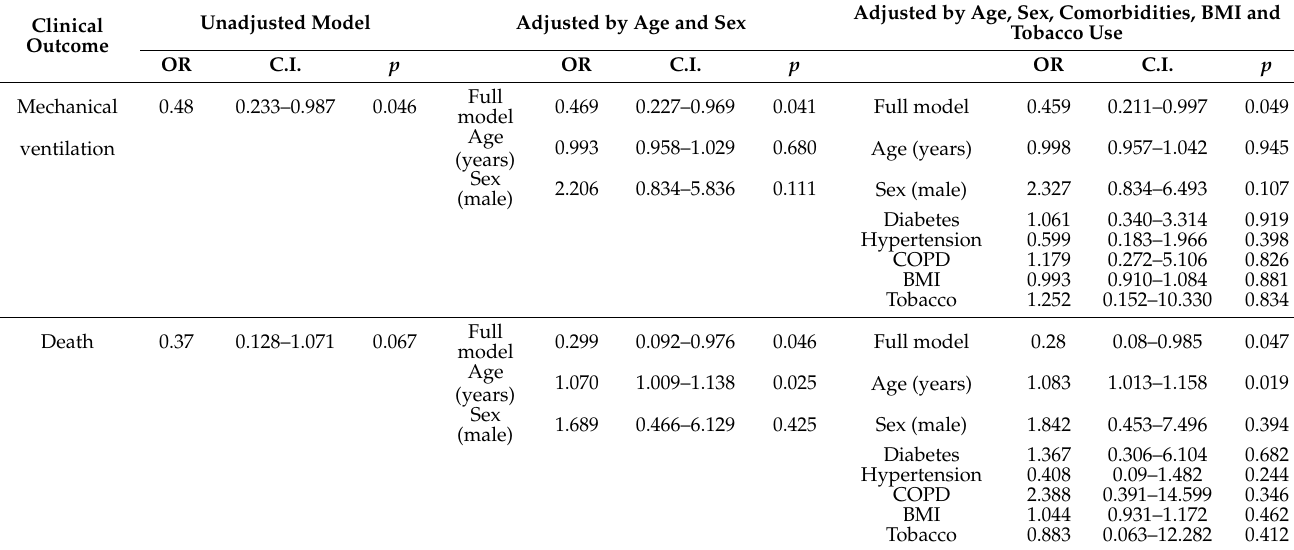
Table 3. Risk of mechanical ventilation and death among the highest and lowest O3I quartiles compared to other quartiles of patients with severe COVID-19. OR C.I. p * Risk of MV for the lowest O3I quartile (<3.57%) compared 1.348 0.925–1.964 0.183 to higher quartiles Risk of death for the lowest O3I quartile (<3.57%) 3.111 1.261–7.676 0.032 compared to higher quartiles Reduction in the risk of MV for the highest O3I quartile 0.257 0.083–0.791 0.026 (>4.51%) compared to the lowest quartile Reduction in the risk of death for the highest O3I quartile 0.195 0.024–1.605 0.165 of (>4.51%) compared to the lowest quartile